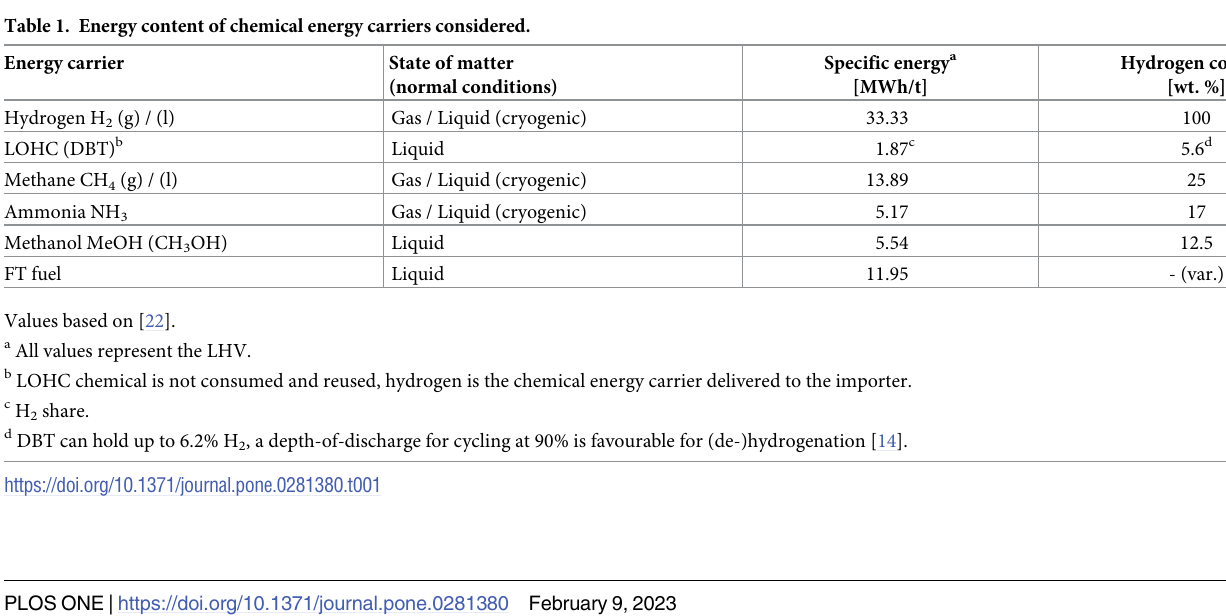
Table 1. Energy content of chemical energy carriers considered. Energy carrier State of matter